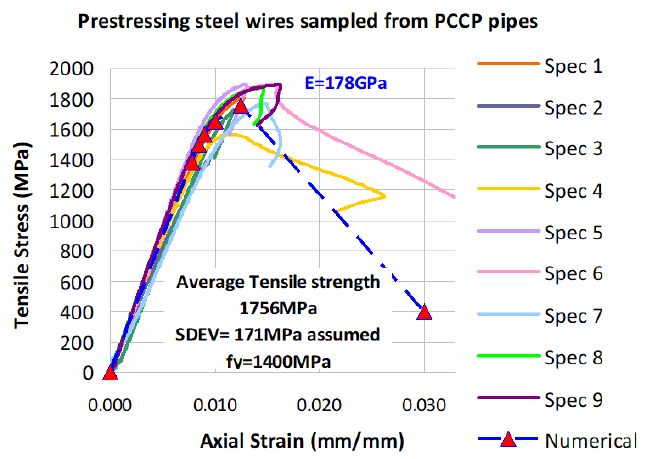
Figure 3. Tensile behaviour of steel membrane coupons taken from tested pipe specimens.